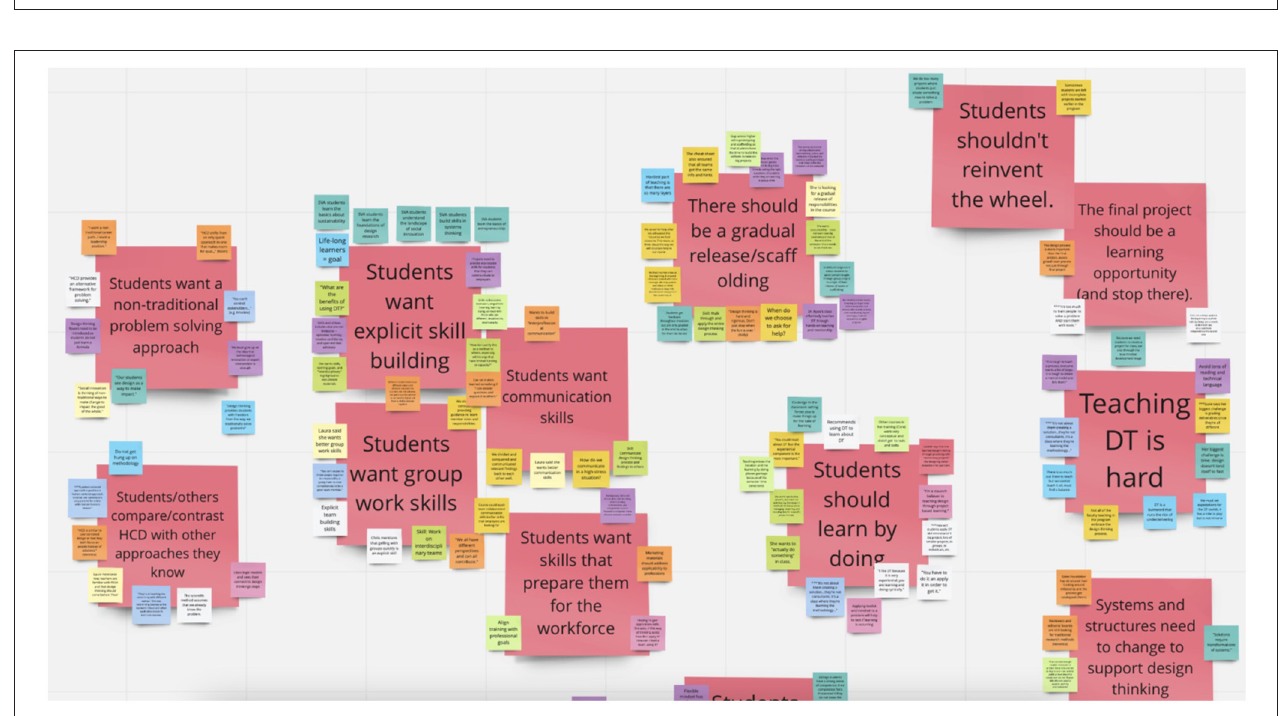
FIGURE 1 | Example Miro board with downloaded learning.